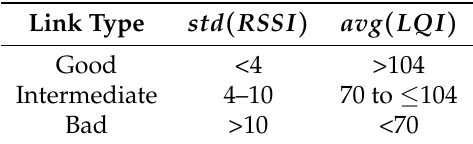
Table 1. Demarcation link types. LQI, link quality